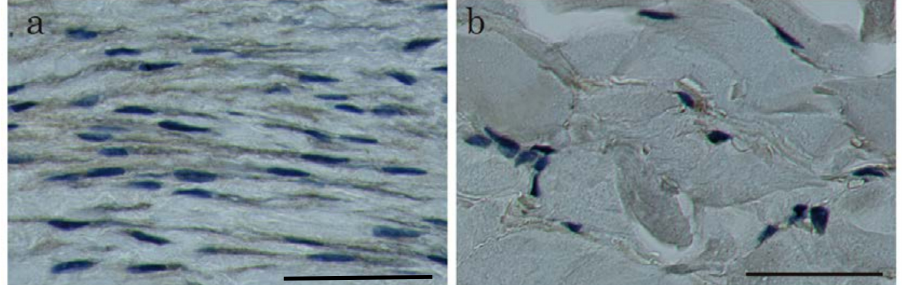
Figure 3. Immunohistochemical staining of HtrA1 protein in keloid ( a ) and normal skin tissue ( b ). Sections from active keloid lesions ( a ) or normal skin ( b ). ( a ) displays the results from patient No. keloid-3 in Table 1, and ( b ) displays the results from patient No. normal skin-1 in Table 1. Positive signals are visualised in brown. Scale bar = 50 µ m.